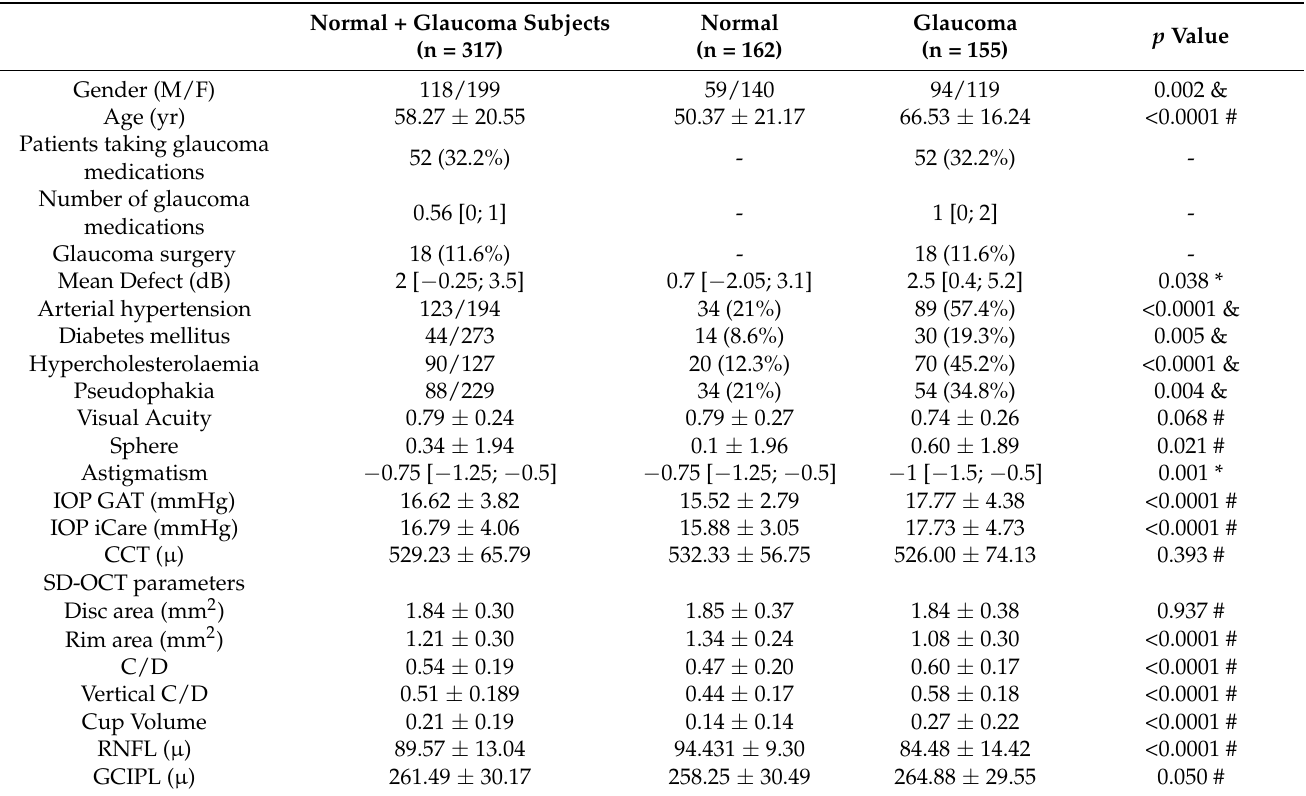
Table 1. Demographic, clinical, and ocular